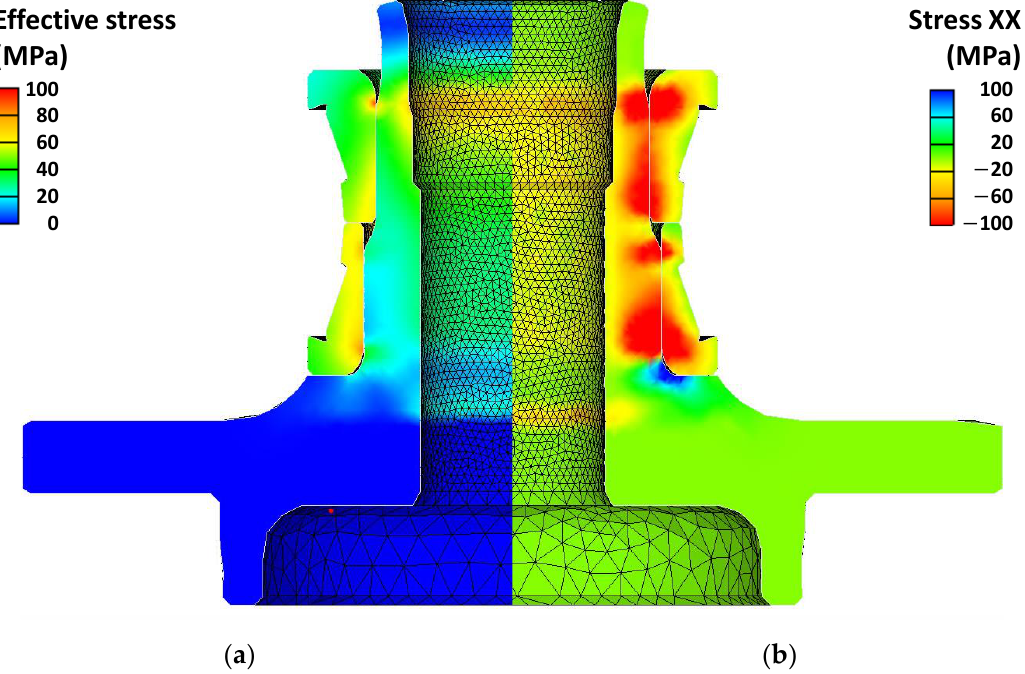
Figure 5. Stresses on the material after tight-fitting of the inner races to the shaft: ( a ) Effective; ( b ) Radial.